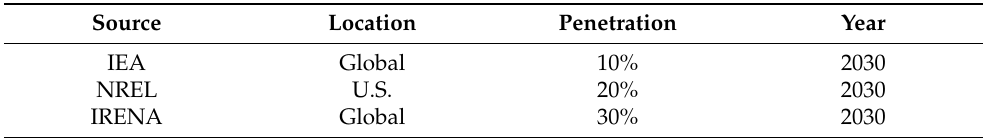
Table 1. Expected EV penetration by 2030 in the U.S. and globally.